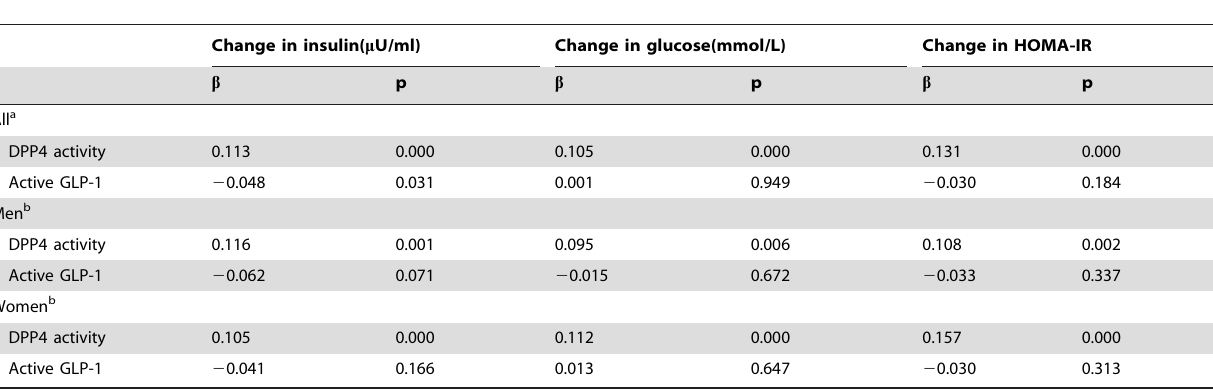
Table 3. Standardized coefficients ( b ) from the multiple linear regression analysis of glucose metabolism in the 4-year longitudinal study.